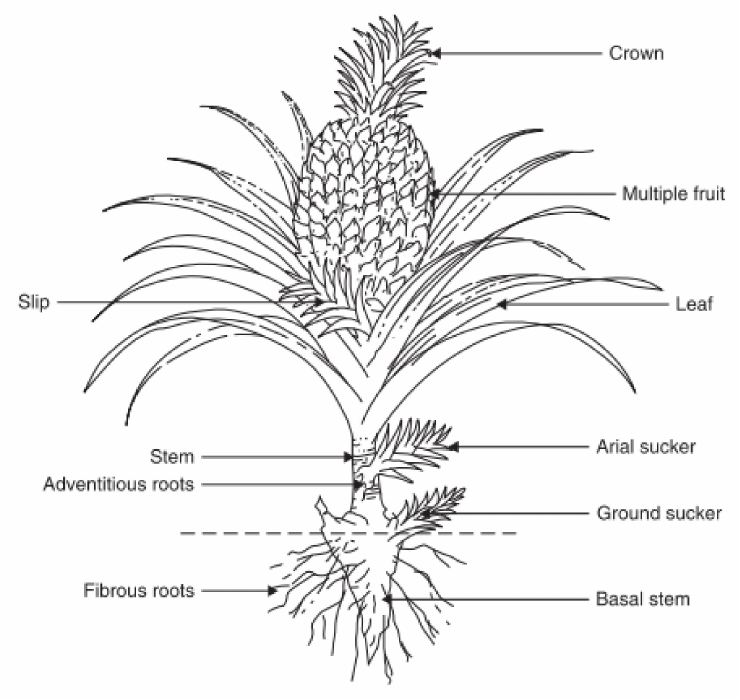
Figure 1. Morphological structure of the pineapple (adapted from Hassan et al.